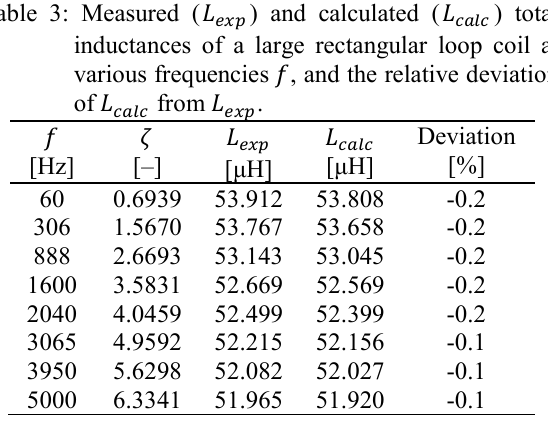
Figure 5: Semi logarithmic plot of the relative error of the logarithm of function (38) for the relative GMD in function of the dimensionless frequency 𝜁 .